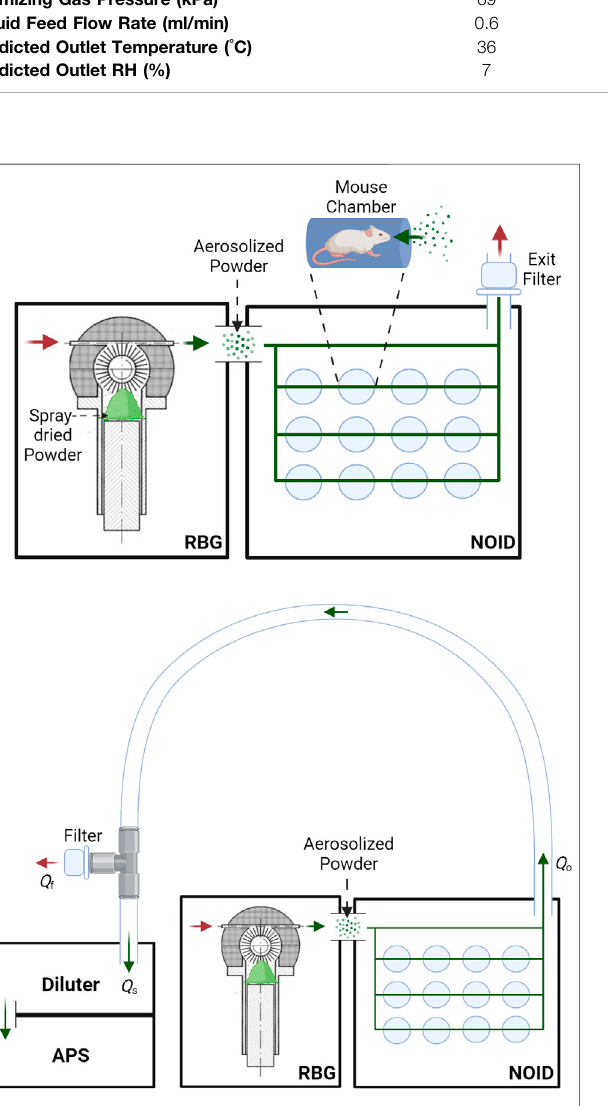
FIGURE 1 | (A) : Schematic of the aerosol delivery system, consisting of the RBG system (Phillips et al., 2017) connected to the NOID. Spray-dried powderisloadedintotheRBGsystem,whichthenaerosolizesthepowder.The powder aerosol traverses the NOID to be inhaled through the nose of the mice.Redarrowsrepresentthe fl owofcleanair,andgreenarrowsrepresentthe fl ow of aerosolized powder. (B) : Simpli fi ed schematic of the system used to assess aerosol particle size at the outlet of the aerosol delivery system. Aerosol particlesizeattheoutletoftheRBG-NOIDwasmeasuredusinganaerodynamic particle sizer (APS). Abbreviations and nomenclature: RBG – Rotating Brush Generator, NOID – Nose-Only Inhalation Device, APS – Aerodynamic Particle Sizer, Q o – fl ow rate at the outlet of the RBG-NOID apparatus (8.33 L/min), Q s – sampling fl owrateoftheAPS(5 L/min), Q f – fl owrateoftheairexitingthe fi lter from the tee fi tting. Figures created with